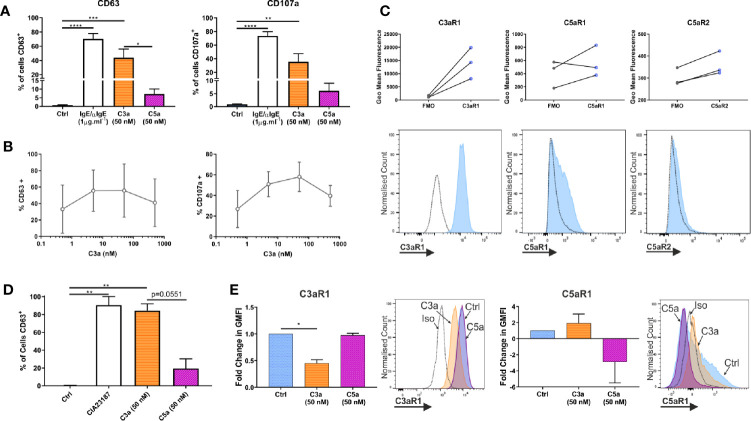
Complement anaphylatoxins differentially induce degranulation. (A) Degranulation measured by externalization of CD63 or CD107a after treatment for 1 h with ligands as shown. Data are mean ± SEM of n=7 independent experiments from 7 separate donors. (B) Degranulation, by CD63 (n=3) or CD107a (n=2) in response to C3a (0.5–500 nM). Data are mean ± SD. (C) Receptor expression based on geometric mean fluorescence, with specific antibodies (blue) vs FMO controls (grey) on hLMCs. Data are n=3 of independent experiments from 3 donors with representative histograms. (D) Degranulation of hLMCs measured by percentage of cells in positive gate for CD63 after 1 h treatment with ligands as indicated. Data are mean ± SEM, of n=3 experiments from three donors. (E) Changes in complement receptor C3aR1 or C5aR1 expression due to anaphylatoxin treatement for 1 h with C3a (50 nM) (orange bar with horizontal stripe) or C5a (50 nM) (magenta bas with diagonal stripe). Data are mean ± SEM of three experiments from three donors with representative histograms showing membrane expression in response to ligands (as labelled). Differences indicated * = p<0.05, ** = p<0.01, *** = p<0.001, **** = p<0.0001 (One-way ANOVA with Dunnett’s or Tukey’s post-tests). Summary statistics are presented in the supplementary material.